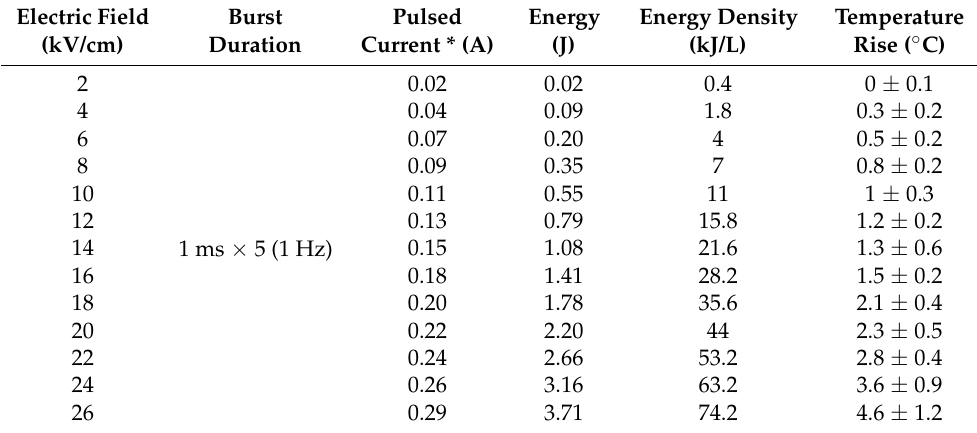
Table 1. The summary of pulsed electric field (PEF)